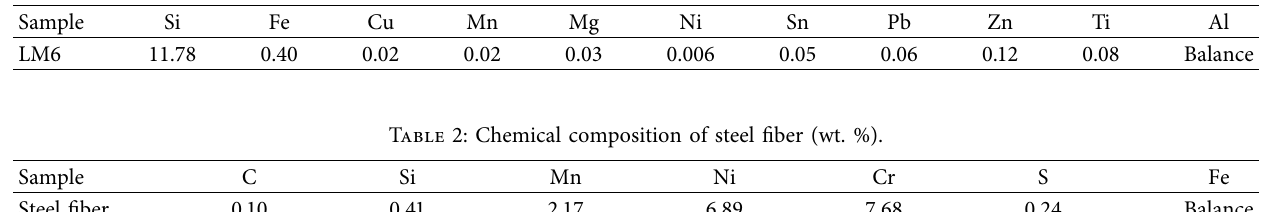
Table 1: Chemical composition of LM6 Al alloy (wt. %).